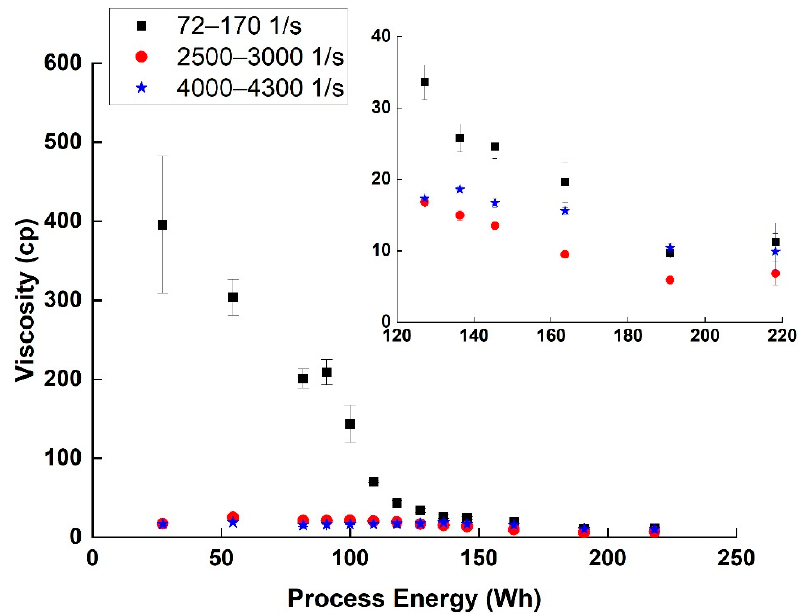
Figure 4. Viscosity averages and SD values ( η in cp) in 3 different shear rate zones for various SWCNT dispersion energies. Inset is a zoom-in on the 120–220 Wh area. By performing the amplitude sweep test, and by comparing the linear viscoelastic region (LVR), G (cid:48) and G (cid:48)(cid:48) , the SWCNT network structure and dispersion viscoelasticity behavior under different energy investments can be better understood. In the initial process steps (up to 164 Wh), the dominant behavior was viscoelastic: initially G (cid:48) was greater than G (cid:48)(cid:48) , and the dispersion showed a gel-like structure (Table 2). After the crossover shear strain value, the relation between G (cid:48) and G (cid:48)(cid:48) was changed, the network structure was broken, and the dispersion behaved like a liquid. Both G (cid:48) and G (cid:48)(cid:48) absolute values decreased with the dispersion energy, indicating again decreased elasticity behavior. At higher processes energy (190 Wh and above), G (cid:48)(cid:48) became dominant in all shear strain range, indicating liquid behavior and high dispersion level of the SWCNT compared to the previous